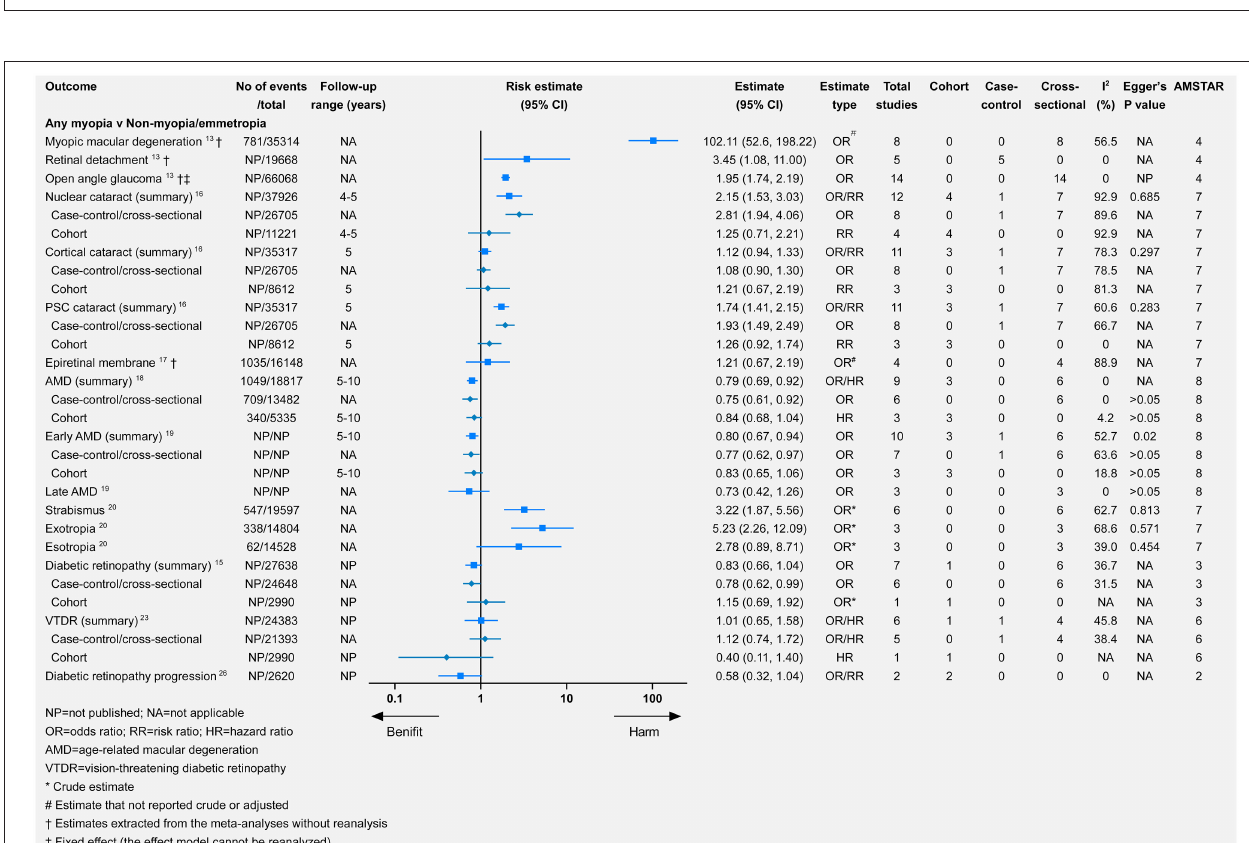
FIGURE 1 | Flowchart of the study selection for the meta-analysis and systematic review.